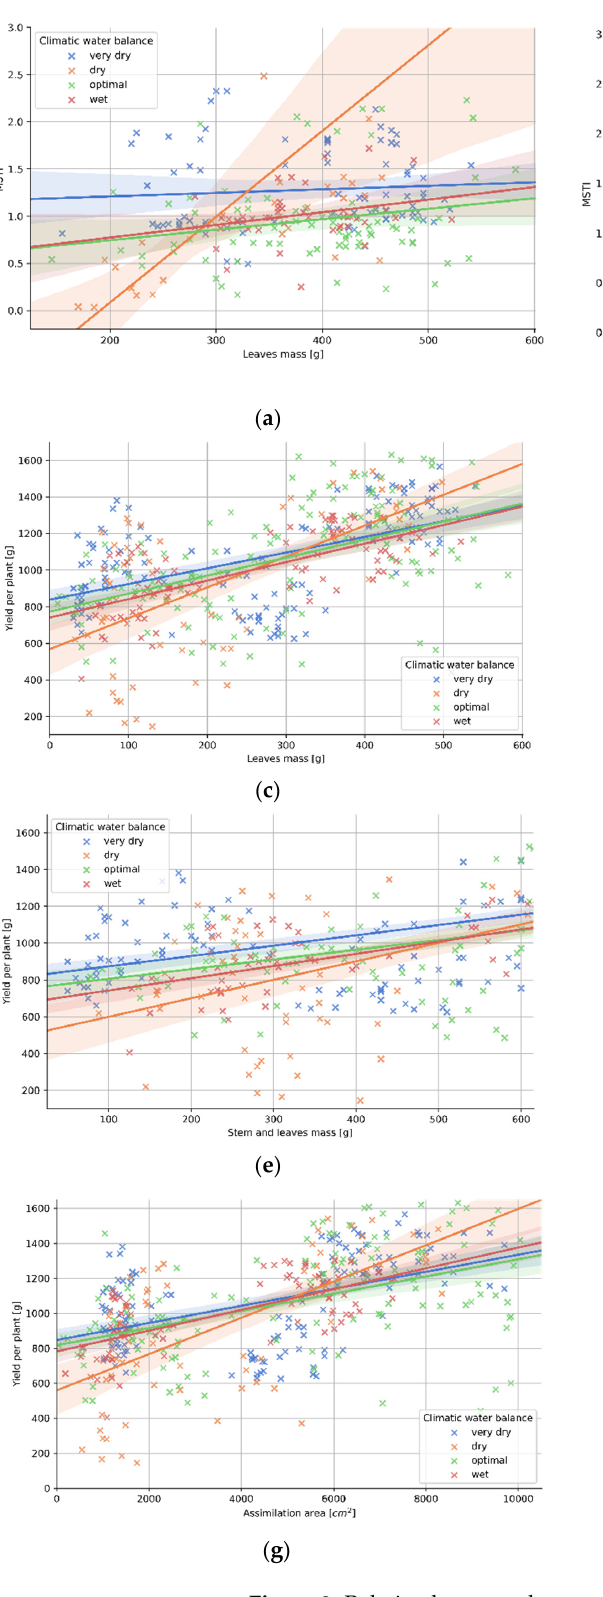
Figure 3. Relation between the agronomic parameters against categories climatic water balance (left side) or against the tolerance to soil drought group (right side) presented for the parameter sets ( a , b ) leaves mass and MSTI, ( c , d ) leaves mass and yield per plant, ( e , f ) stem and leaves mass and yield per plant, and ( g , h ) assimilation area and yield per plant. However, the variance of the measurement is high; again, the measurement values overlapped between the groups, though it was not easy to distinguish them. Additionally, the correlation coefficient for those groups was quite low (Table 4). Table 4. Linear modeling results for relation between agronomic parameters against categories: cli- matic water balance or against tolerance to soil drought group, presented for parameters sets: (a) & (b) leaves mass and MSTI, (c) & (d) leaves mass and yield per plant, (e) & (f) stem and leaves mass and yield per plant, (g) & (h) assimilation area and yield per plant. (a) Climatic Water Balance p -Val. 1